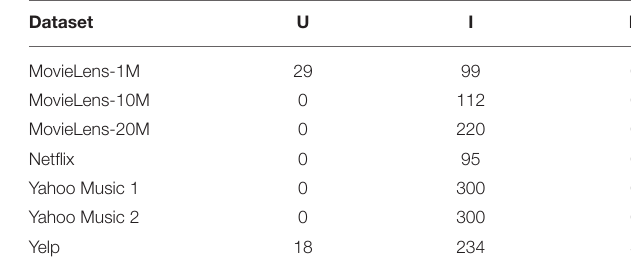
TABLE 8 | Attribute statistics of datasets.